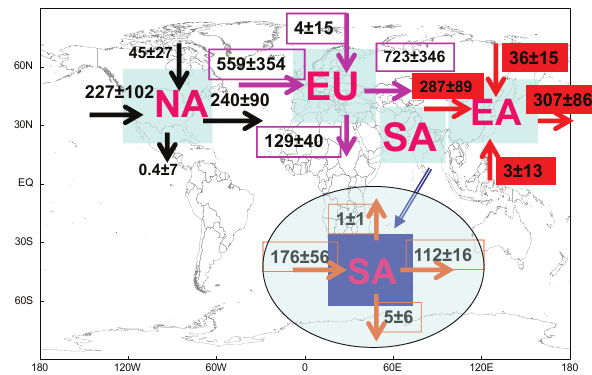
Fig. 1. Annual net mass (Tgd − 1 ) of aerosols transported through the borders of four HTAP regions with the transport directions fol- lowing the arrows, the mean values and the standard deviations over the 10-yr of